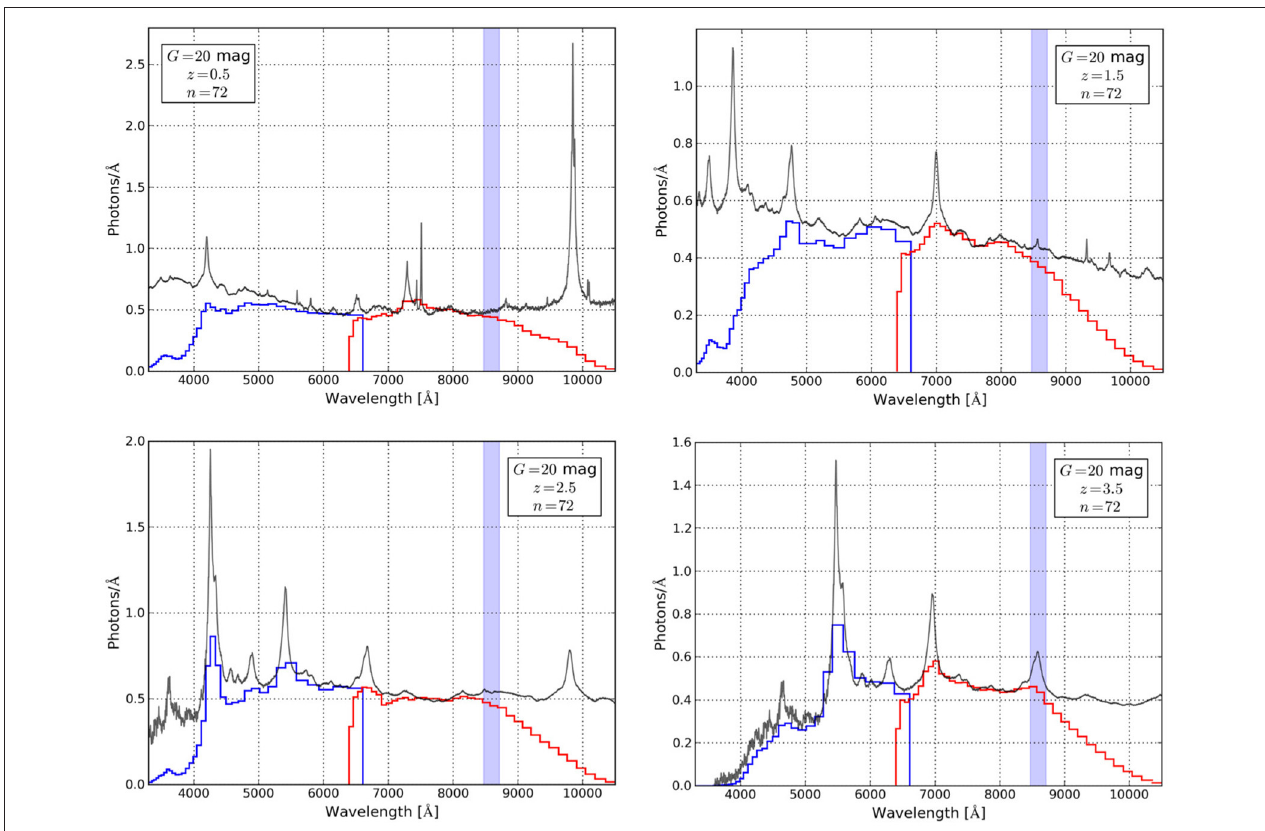
FIGURE 3 | Ability of Gaia to determine redshifts of quasars with G = 20 (corresponding to V ≈ 20.2) after a median of 72 exposures collected over a 5-year mission. From Proft et al. (2015), with permission.